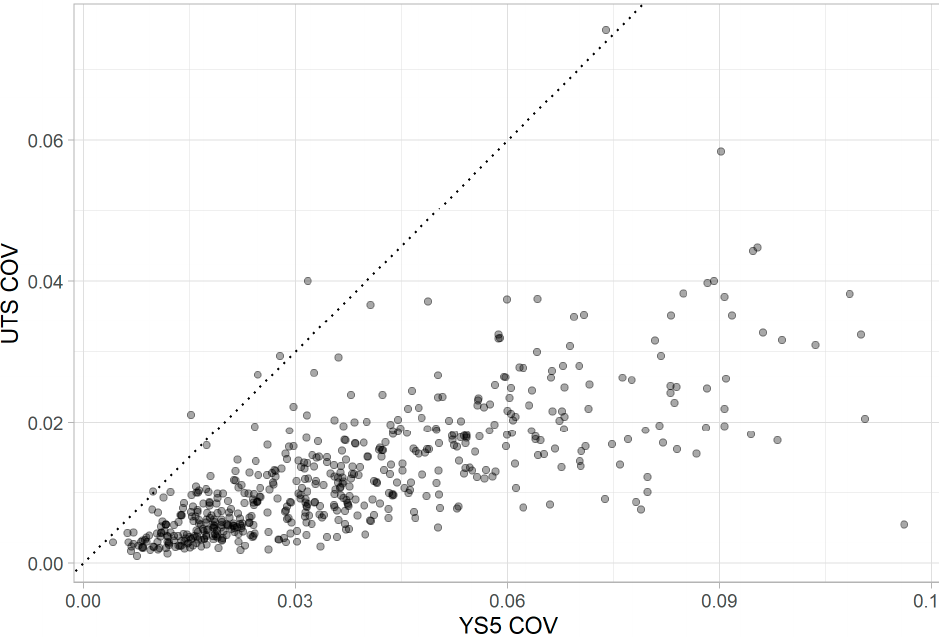
COV for YS. The trend shown by the histograms in Figure 5a is emphasized in Figure 6.